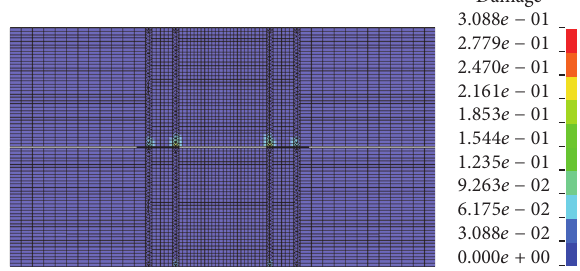
Figure 14: Damage area on the top of box girder under the velocity load of 2 cm/s.